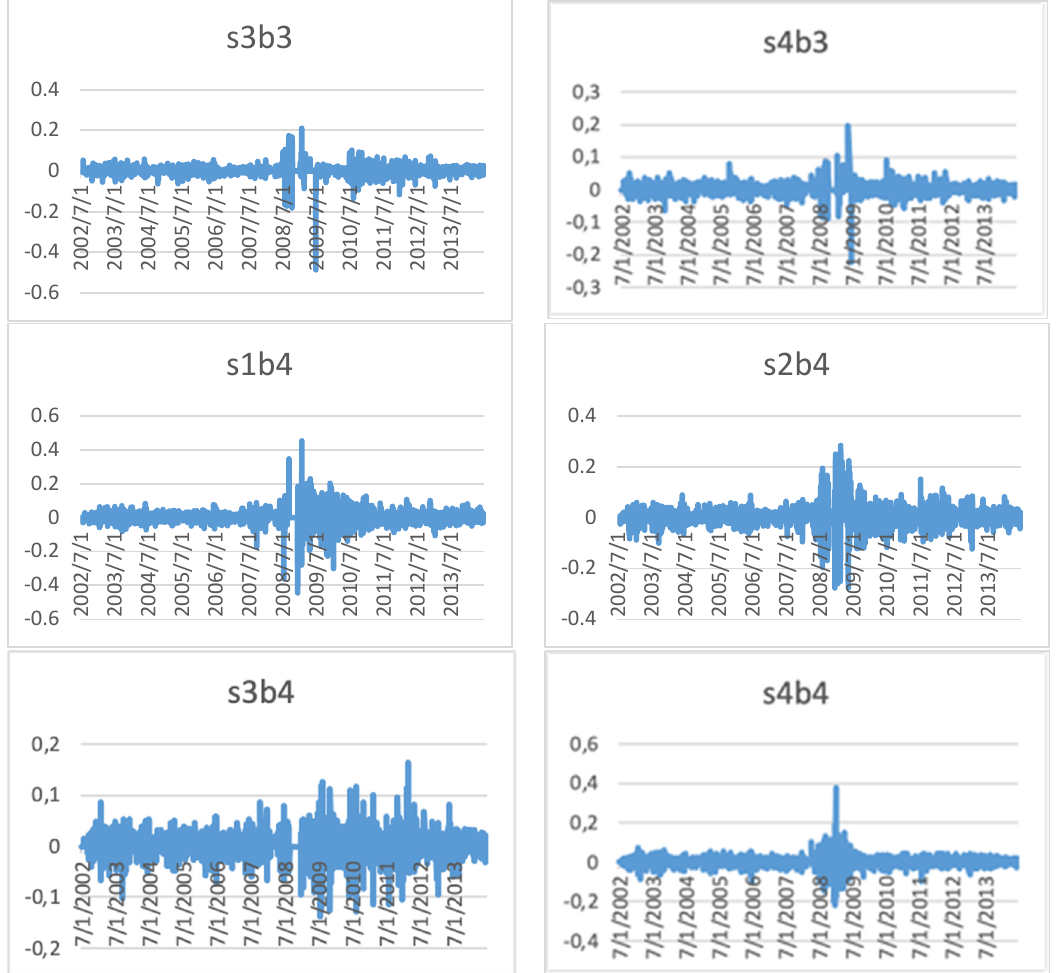
Figure A2. Daily Returns of Size (S) (S1 Represent the Small Quantile of Size Factor, S4 Is the Large Quantile of Size Factor)) and Beta (b) (b1 Is the Low Beta Quantile and b4 Is the High Beta Quantile, b2 and b3 Represent Medium Beta Quantiles)) Portfolios.